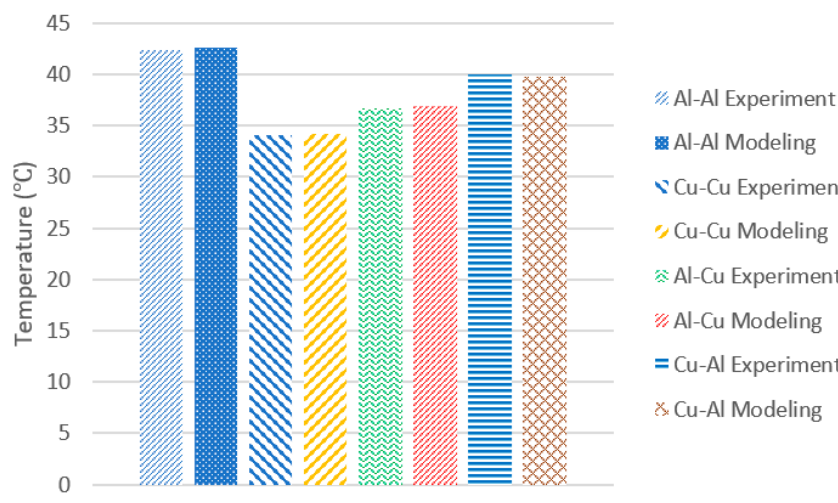
Figure 13. Modelling vs. experiment.